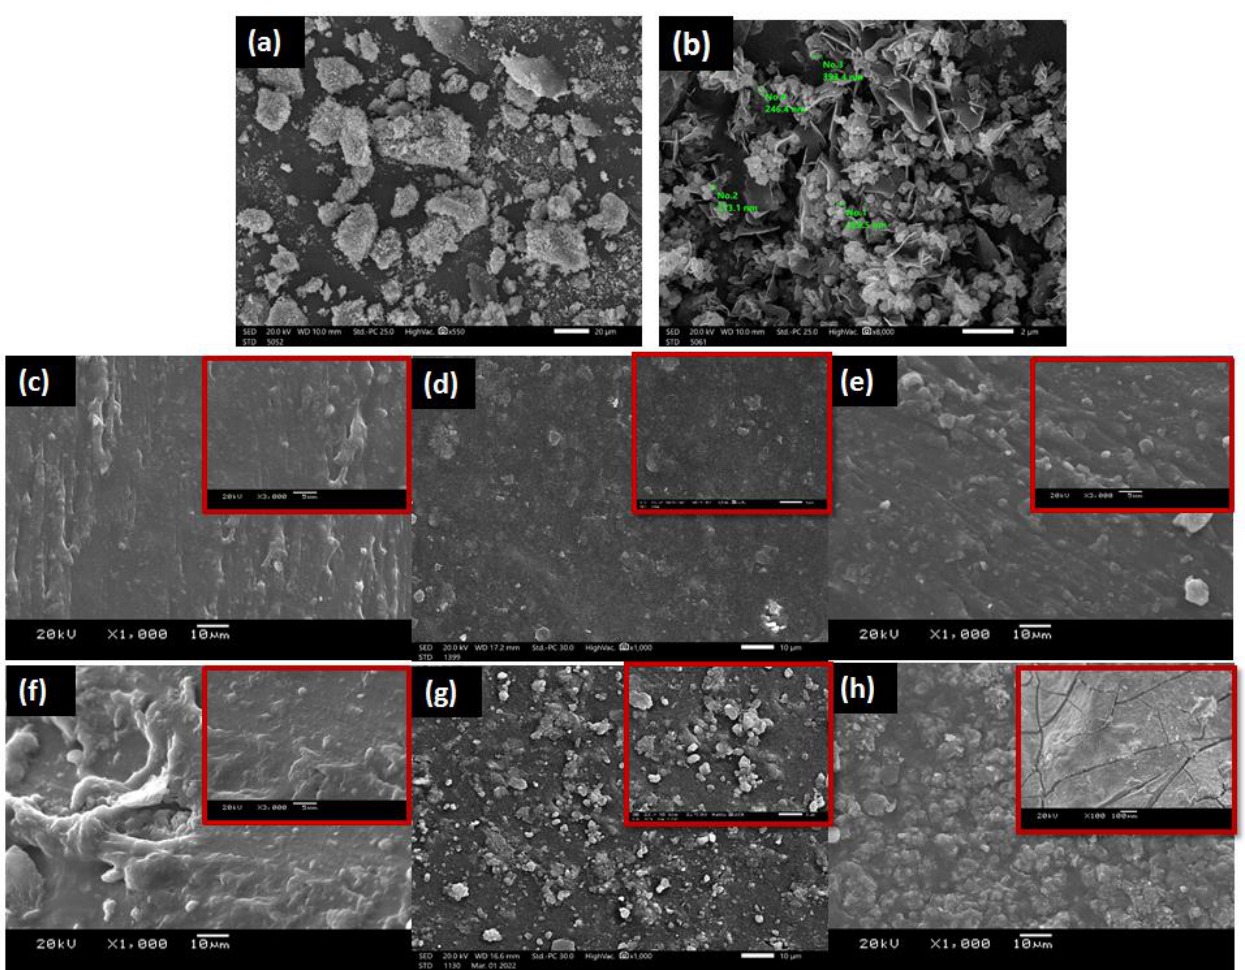
Figure 5. SEM images of nanohydroxyapatite (nHA) powder ( a , b ) with different magnifications (550×, 8000×, respectively). Surface investigations of the prepared nanocomposite hydrogels loaded with different contents of nHA: ( c ) 15% GA/chitosan/0% nHA, ( d ) 15% GA/chitosan/5% nHA, ( e ) 15% GA/chitosan/10% nHA ( f ) 25% GA/chitosan/0% nHA ( g ) 25% GA/chitosan/5% nHA ( h ) 25% GA/chitosan/10% nHa.